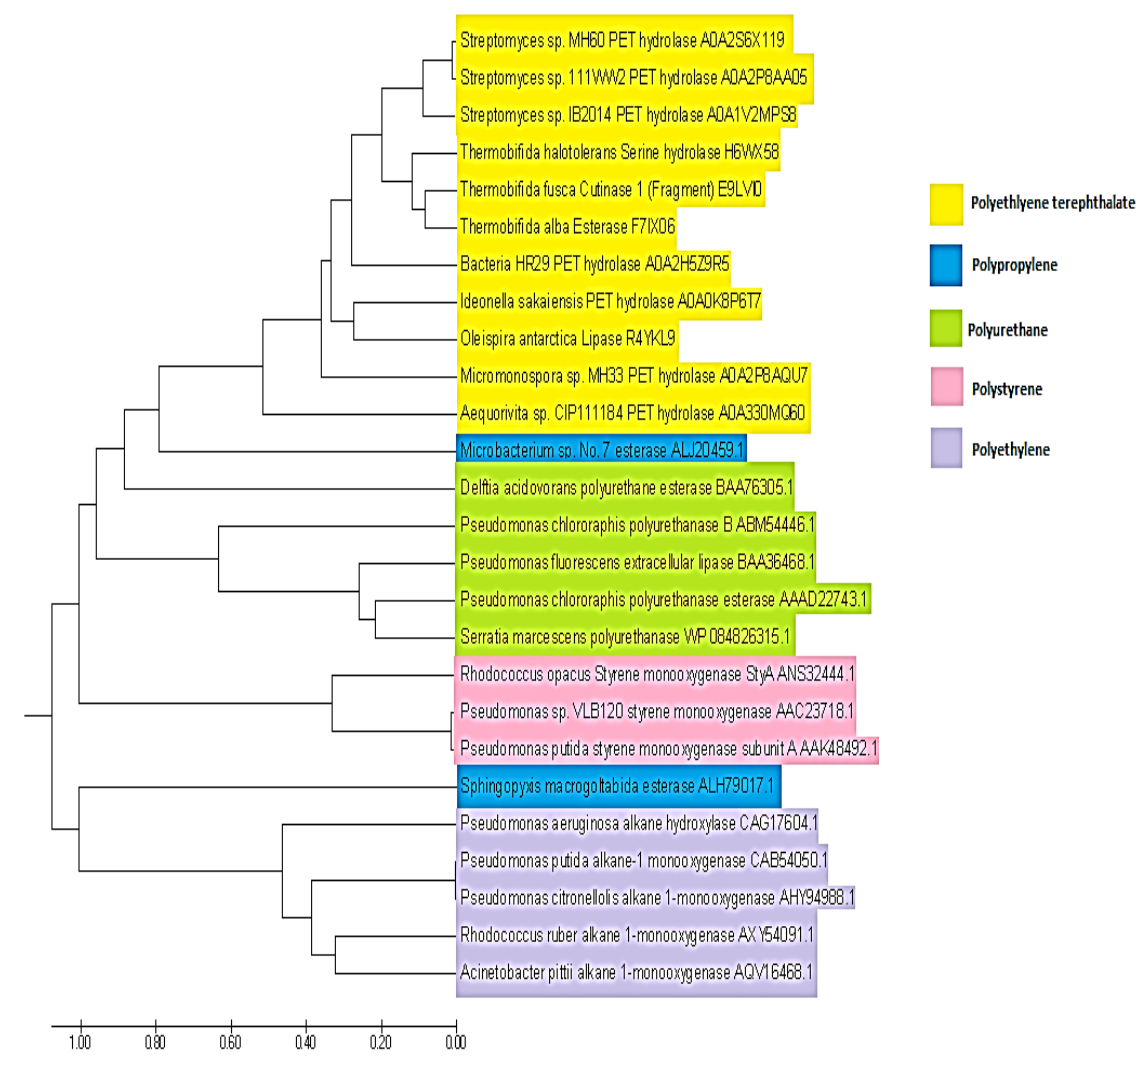
Figure 4. Phylogenetic relationships among bacteria for degradation of microplastics. A phylogenetic tree constructed based on amino acid sequence homologies of synthetic plastic polymer-degrading enzymes in bacteria is drawn. The tree was constructed with Molecular Evolutionary Genetics Analysis v7 (MEGA7, https://www.megasoftware.net/ (accessed on 20 November 2022)). Schimdt et al. [72] analyzed the ability of four polyester hydrolases, LC Cutinase (LCC), TfCut2, Tcurl278, and Tcur0390 to degrade polyester PU Elastollan B85A-10